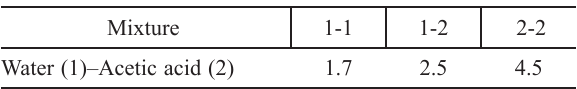
Table 6 – Parameters of Hayden-O’Connell correlation model for the acetic acid-water system